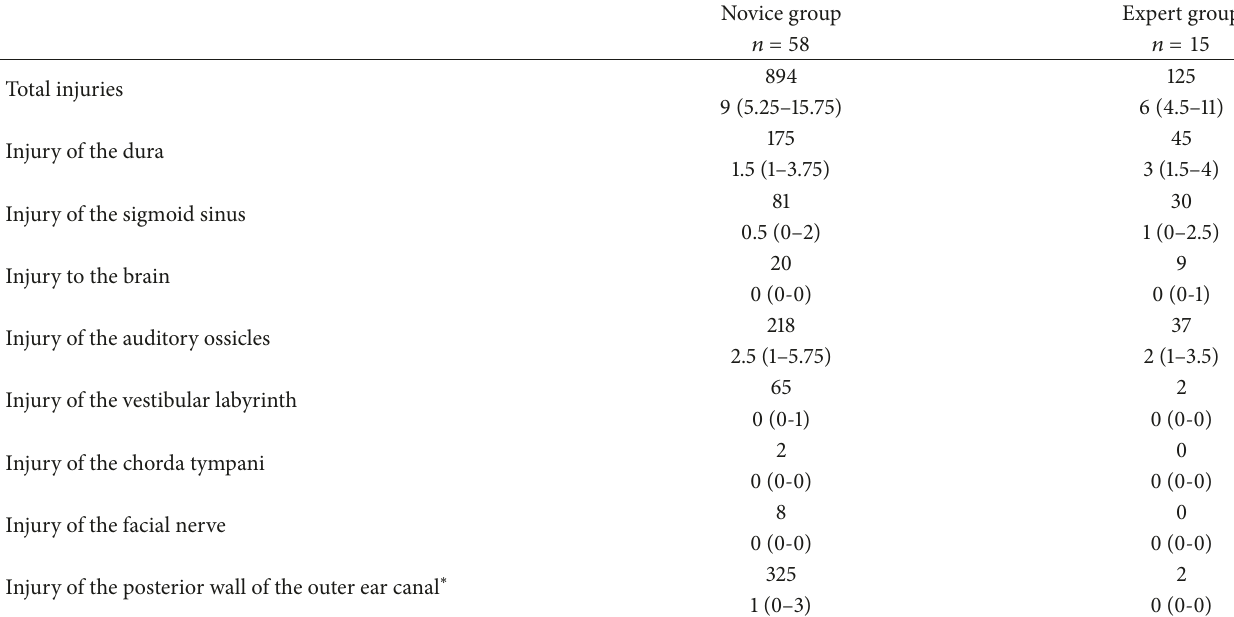
Table 2: Injuries of structures at risk.